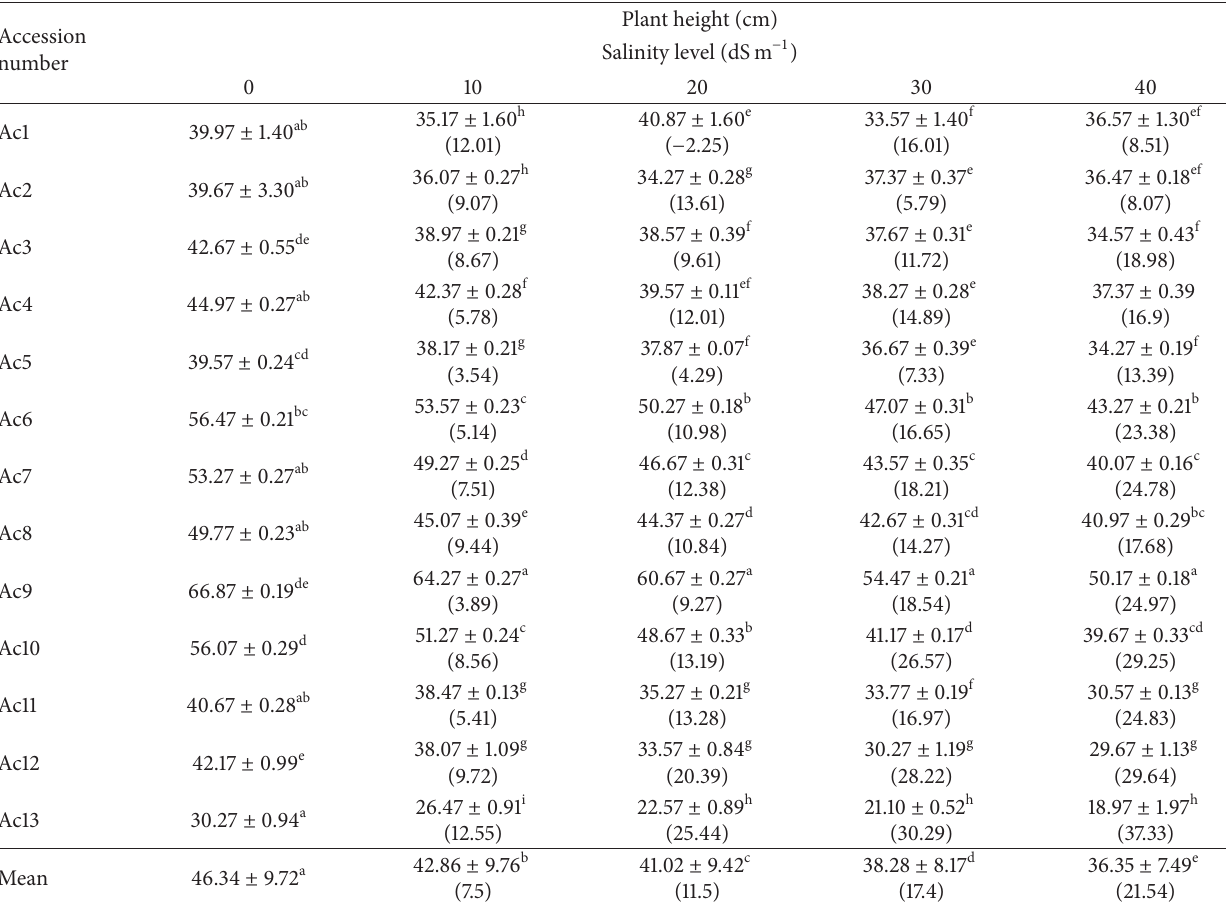
Table 4: Effect of salinity on plant height of 13 salt treated purslane